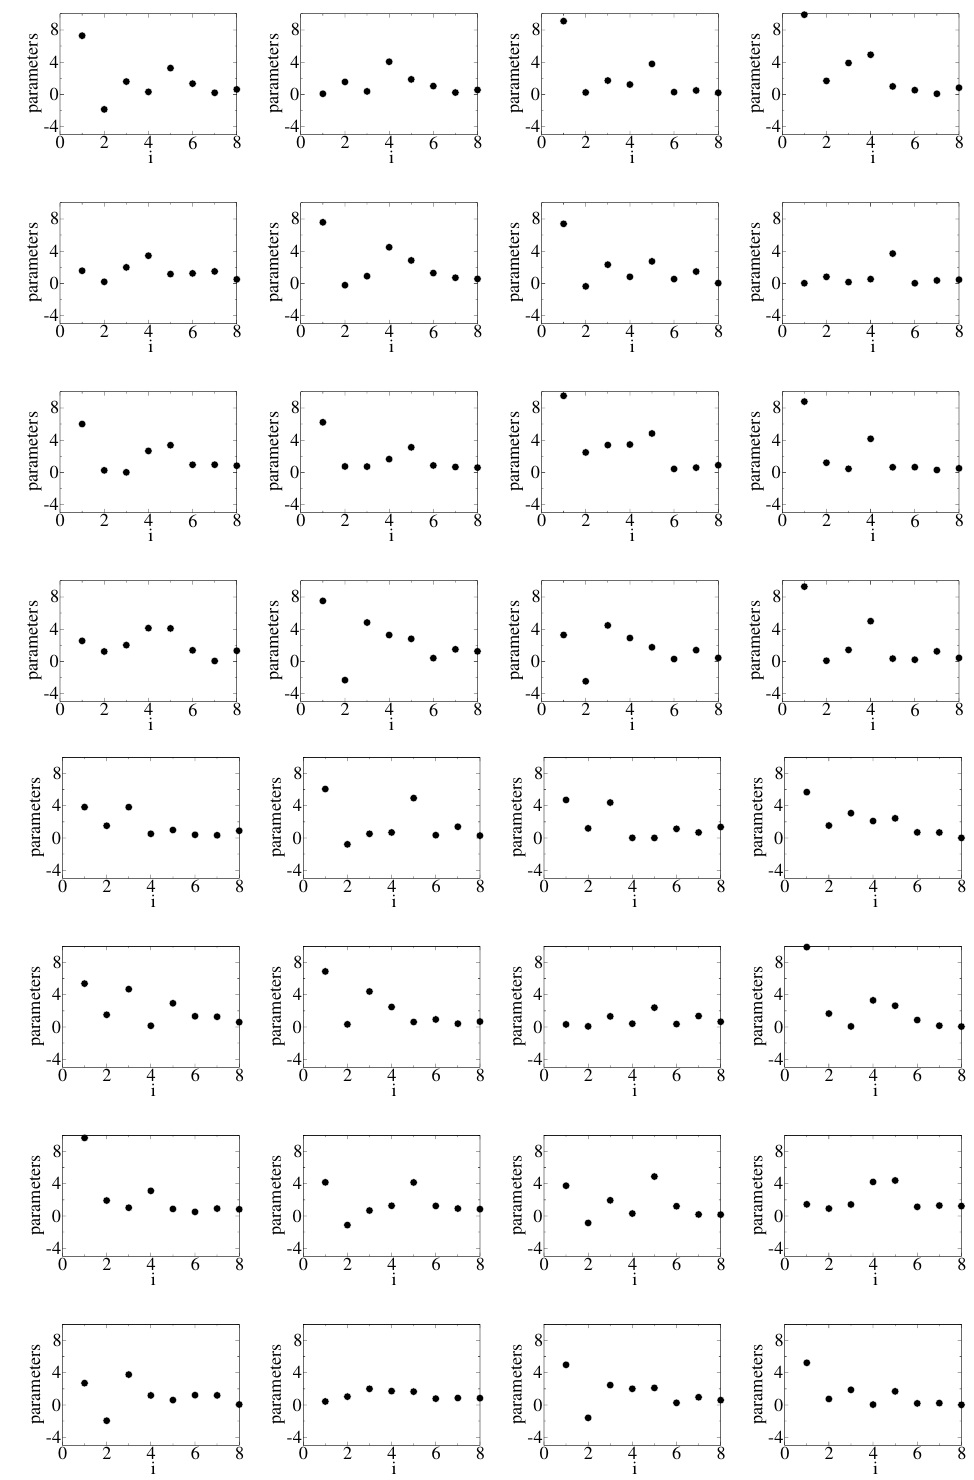
Figure 4. The input parameters of the 32 samples used in Figures 2 and 3; i = 1 corresponds to U ; i = 2 corresponds to (cid:101) f ; i = 3,4,5 correspond to (cid:101) 1 , (cid:101) 2 , (cid:101) 3 ; and i = 6,7,8 correspond to t 1 , t 2 , t 3